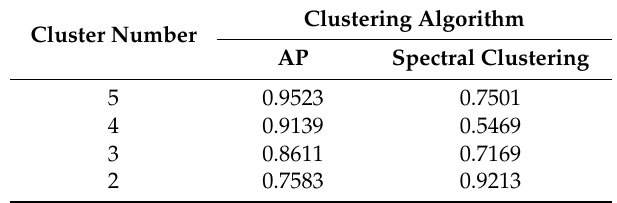
Figure 8. Clustered similarity matrices for discharge curves; ( a ) The AP algorithm; ( b ) The spectral clustering algorithm. Table 2. Silhouette indexes for the discharge curves.